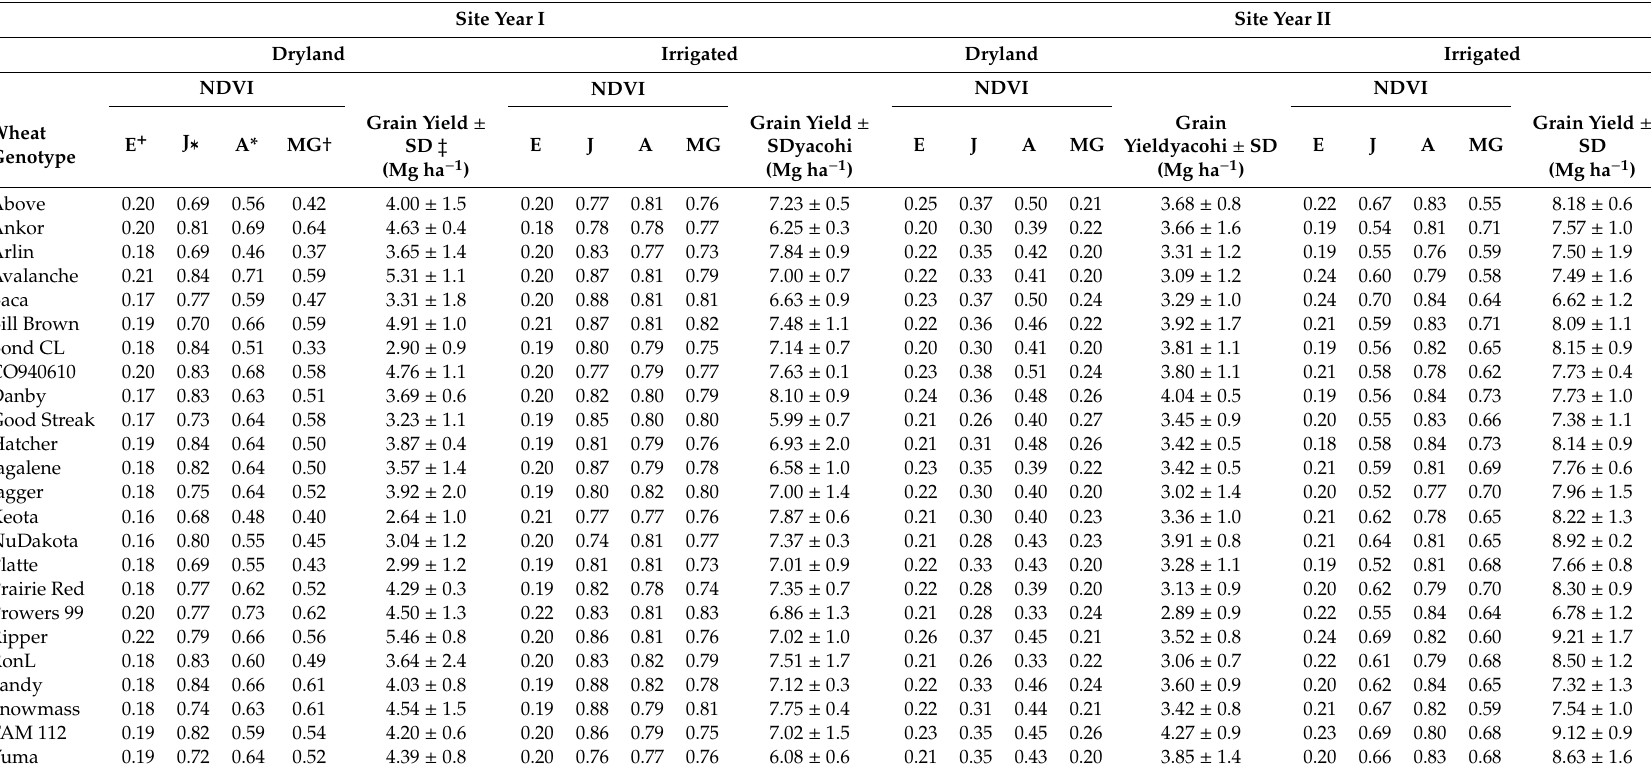
Table 2. Mean grain yield of 24 winter wheat genotypes and mean NDVI values at four growth stages under two irrigation conditions across two site